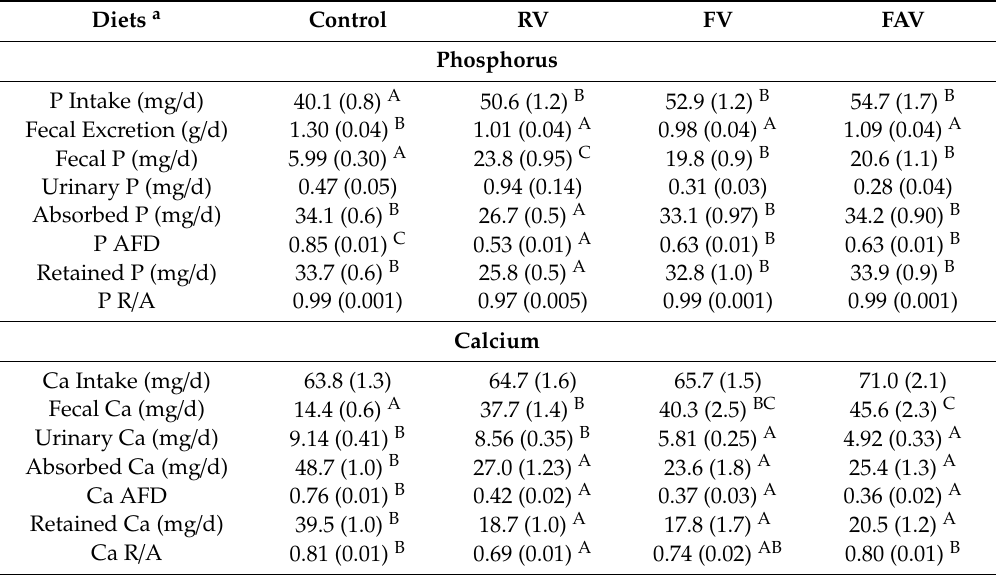
Table6. E ff ectofnaturalfermentationonthenutritiveutilizationofPandCafrom Vignaunguiculata